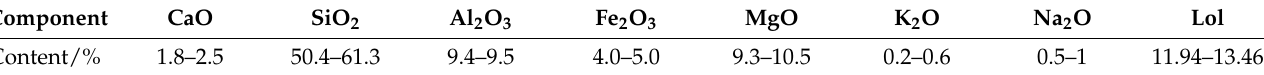
Table 1. Composition of NAC.